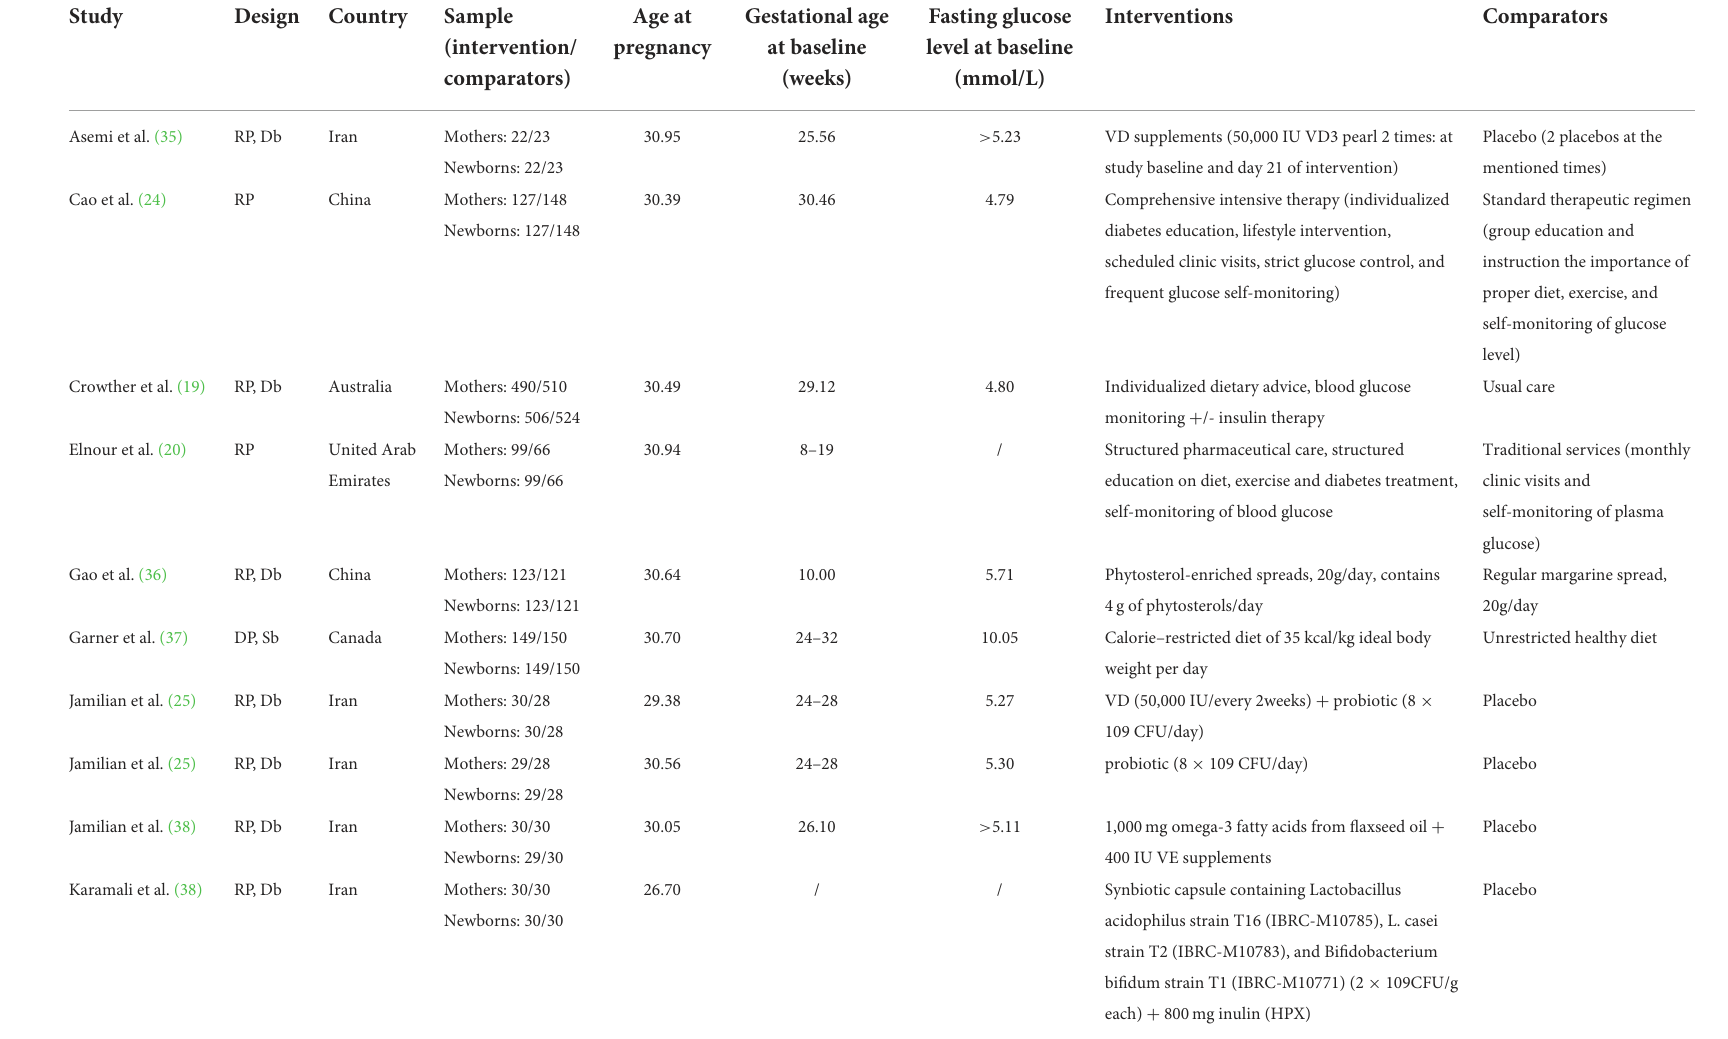
TABLE 1 Characteristics of included studies in this meta-analysis (18